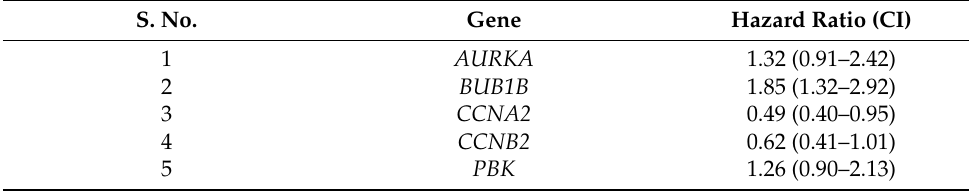
Table 5. Table showing the survival analysis results of hub genes in breast cancer. S.